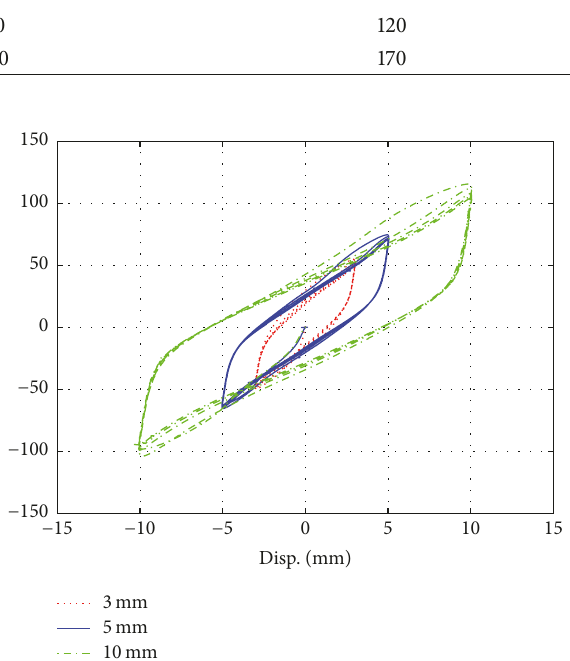
Figure 11: Force-displacement curves of the typical MHD for large